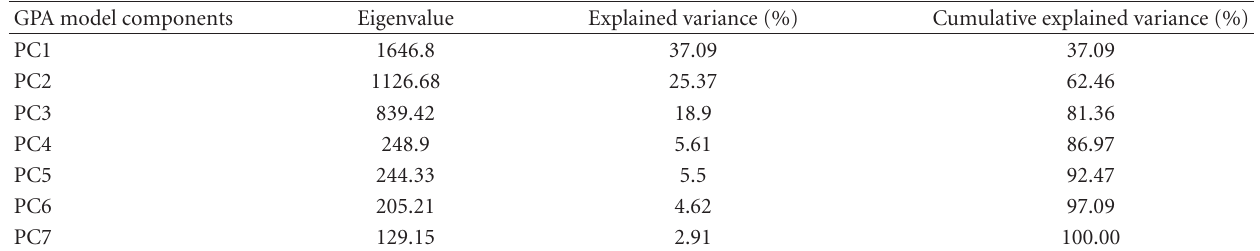
Figure 5: PC1–PC3 slice of the model showing test items plotted into the GPA model. The brown and green arrows clarify the dimensions of content (PC1) and room acoustics (PC3). Table 3: Seven principal components (also dimensions or factors) of the Generalized Procrustes Analysis, their Eigenvalues, and the percentage of explained variance of the GPA